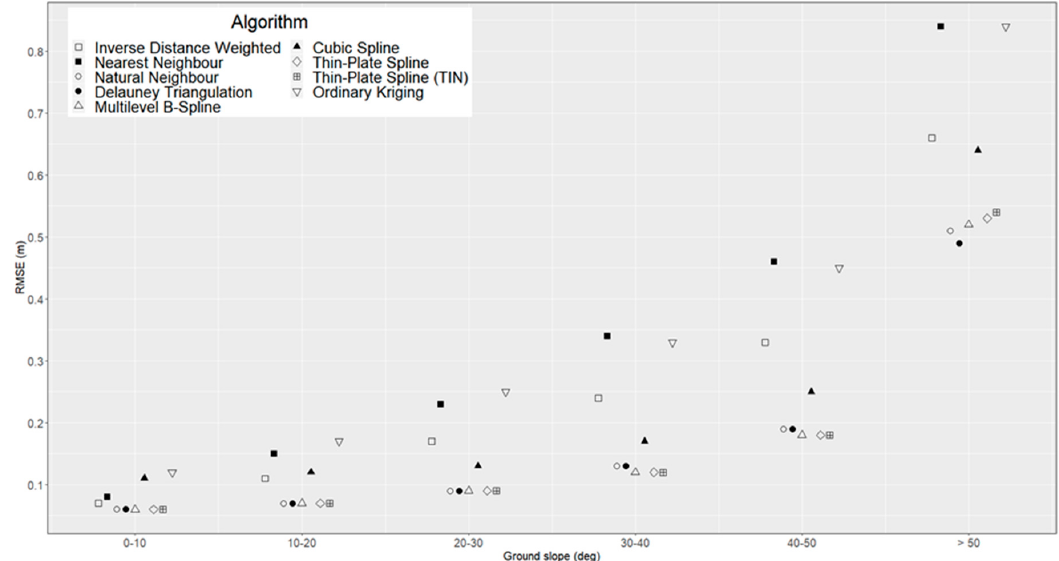
Figure 4. Variation of interpolation accuracy by ground slope class (model resolution: 0.5m). For clarity, points are horizontally offset.